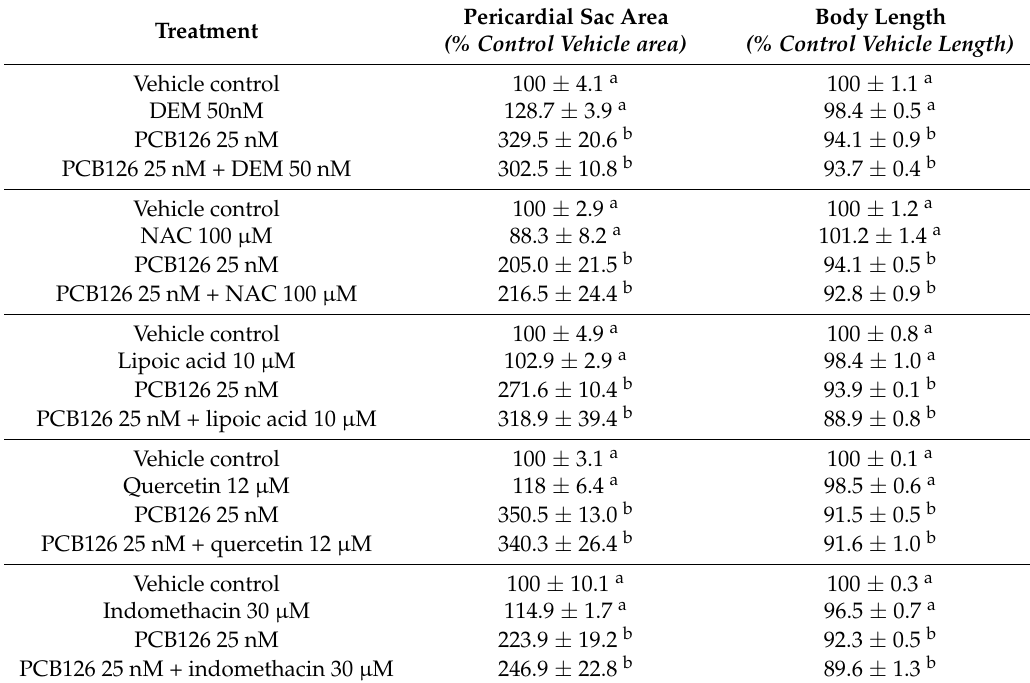
Table 3. Pericardial sac area and body length of larvae at 3 dpf exposed to PCB126 and co-exposed to several redox-modulating chemicals. Data are presented as mean ± SEM on n = 3–5 pools of three embryos. Different letters on top of the bars indicate statistically significant differences with p <